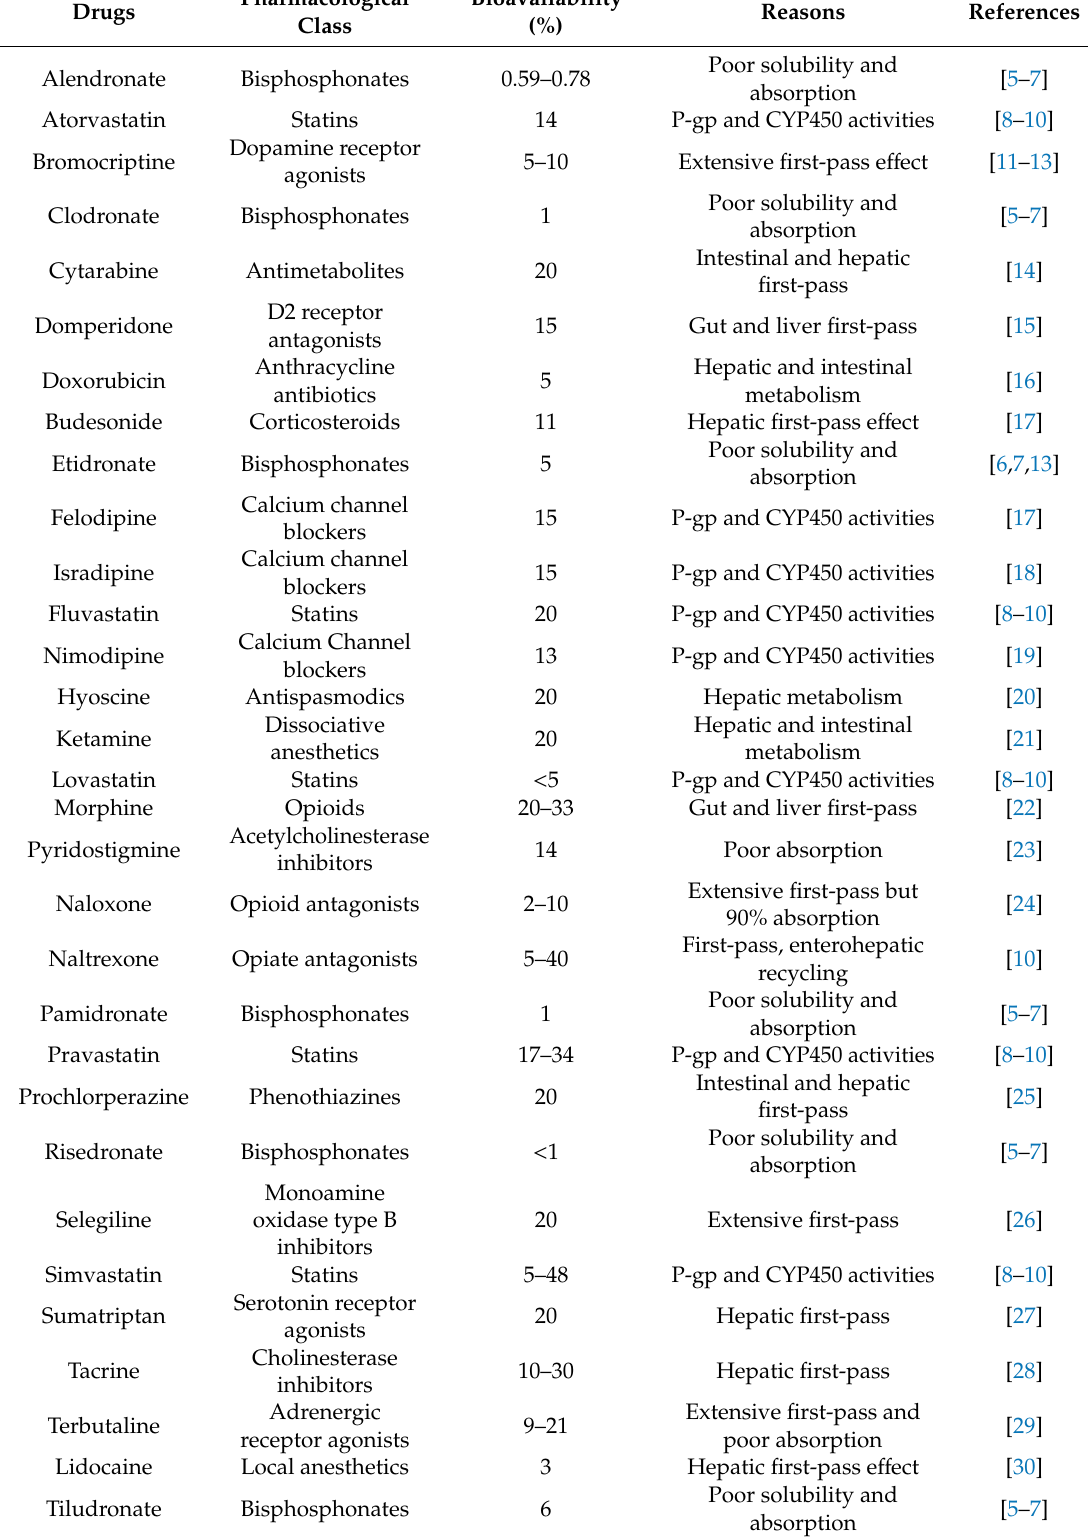
Table 1. Examples of drugs with very poor bioavailability with reported